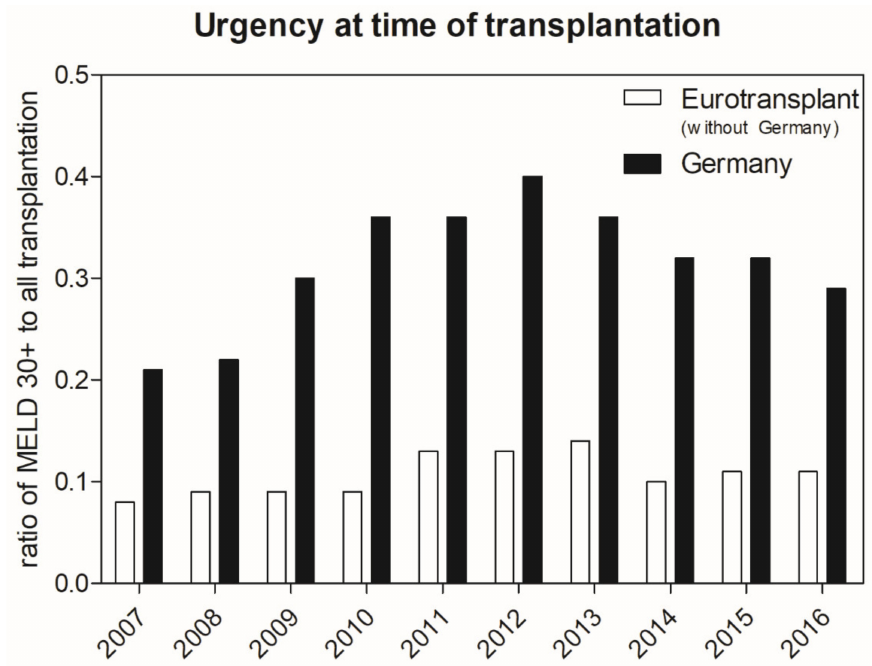
Figure 3. Urgency at time of transplantation in German compared to the Eurotransplant area. Urgency is displayed as the ratio of patients with a high MELD score (MELD ≥ 30). Evidently, liver transplant recipients in Germany have a higher urgency compared to the other partner countries of Eurotransplant ( p < 0.001). This di ff erence may be caused by several factors, such as di ff erent laws concerning organ donation (e.g., opt-out rule in Belgium, Austria, and others) and type of allocation (e.g., center-based allocation). Source: Annual reports of Eurotransplant. MELD, Model for End-Stage Liver